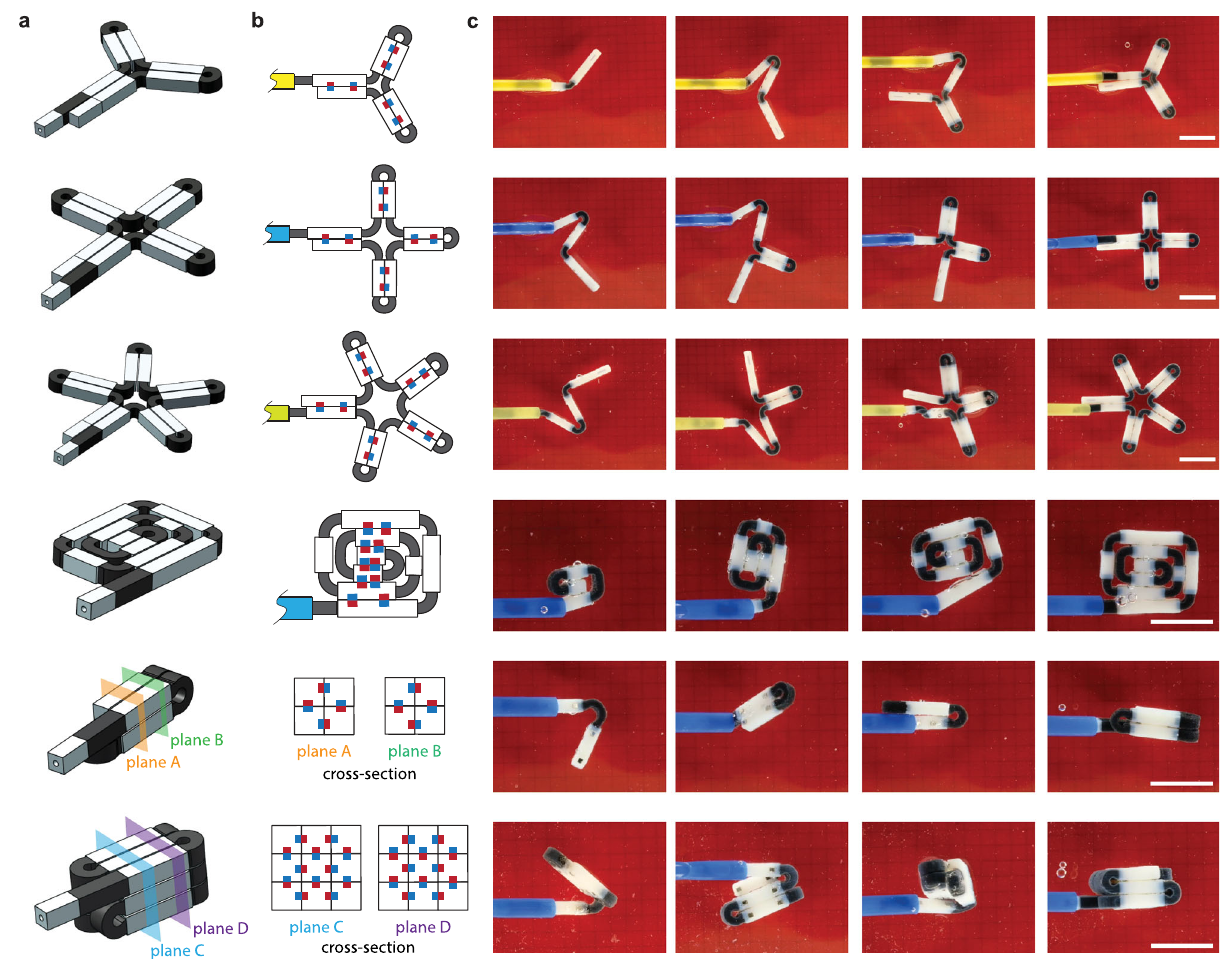
Fig. 3 | Dynamic folding process of complex 2D and 3D geometries. The 3D design, structure diagram, and dynamic folding process are shown in panels